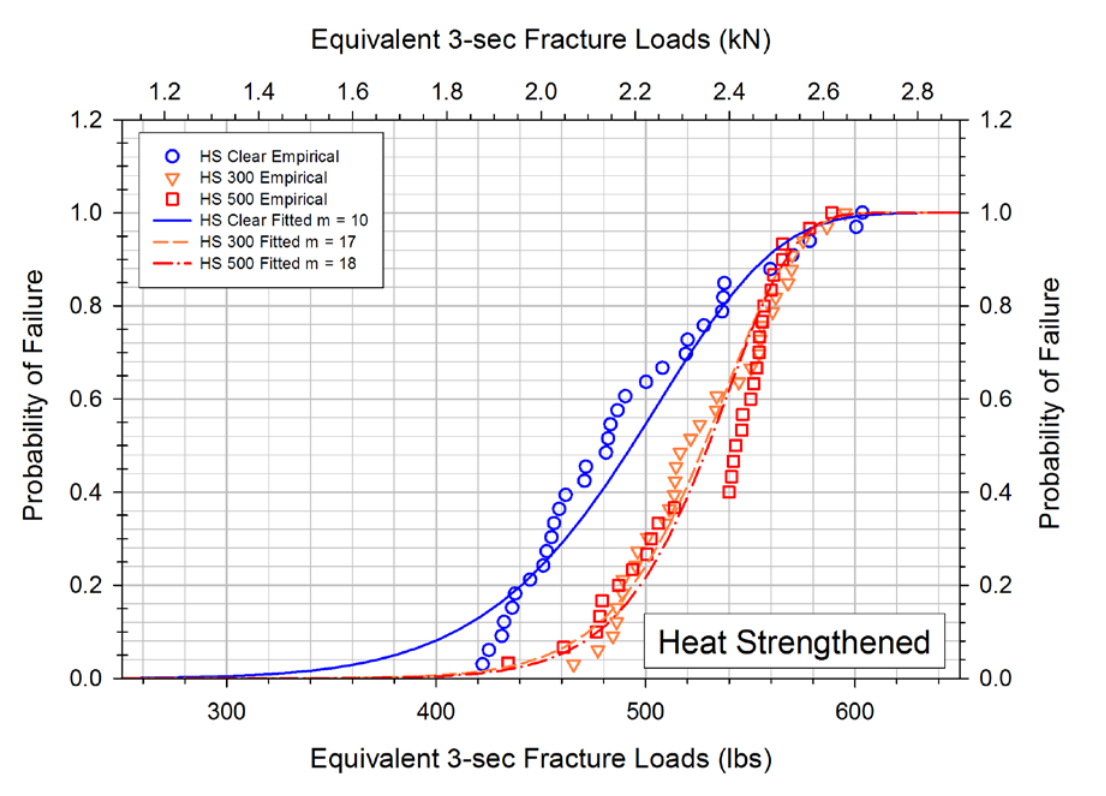
Figure 4. Cumulative distribution function for the probability of failure for clear HS, OPACI-COAT-300®, and OPACI-COAT-500® specimens.